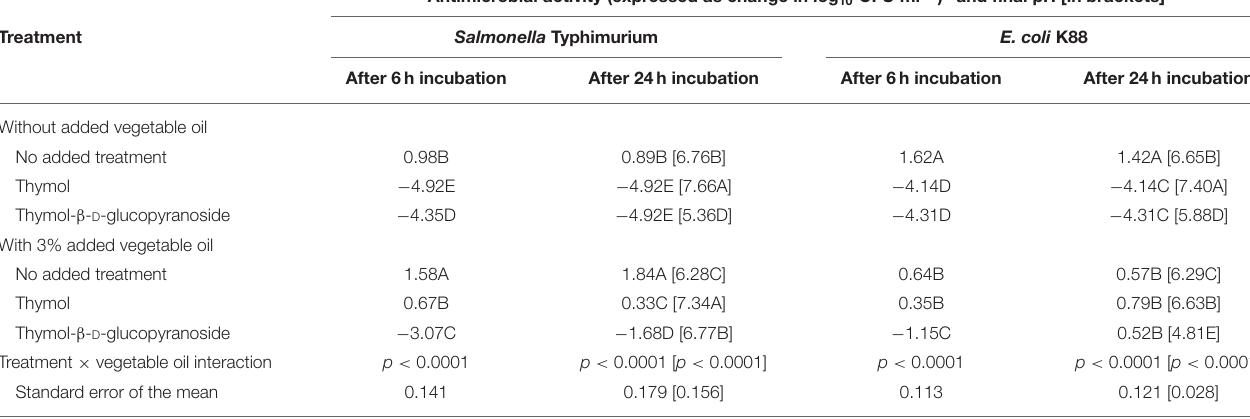
TABLE 1 | Effects of added vegetable oil on anti- Salmonella Typhimurium and anti- E. coli K88 activities of thymol or thymol- β - D -glucopyranoside (6mM) and on final pH during mixed culture with porcine fecal